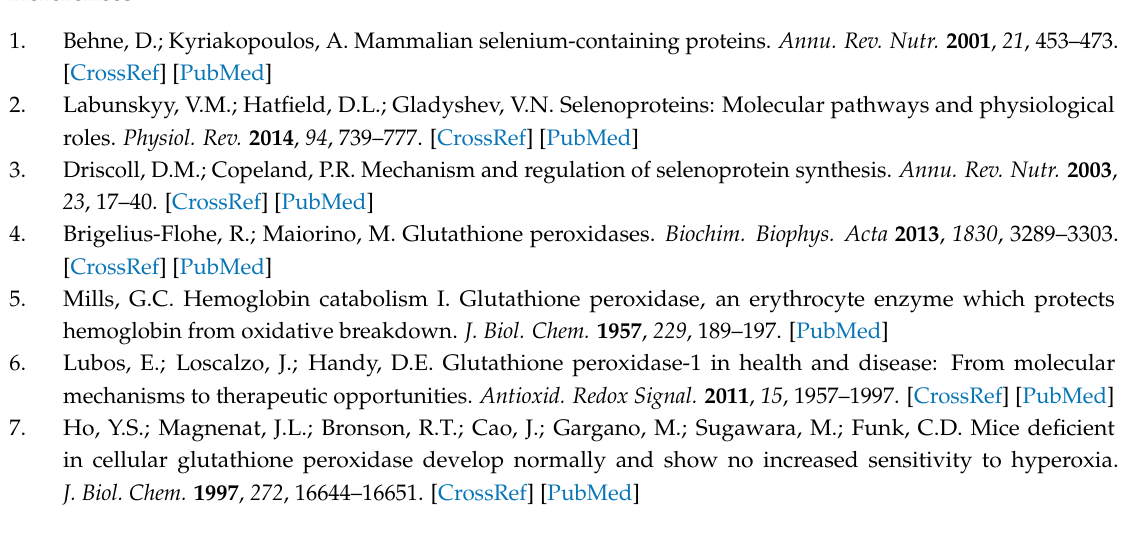
Figure S1: Specificity of the GPX1 antibody was confirmed with a blocking